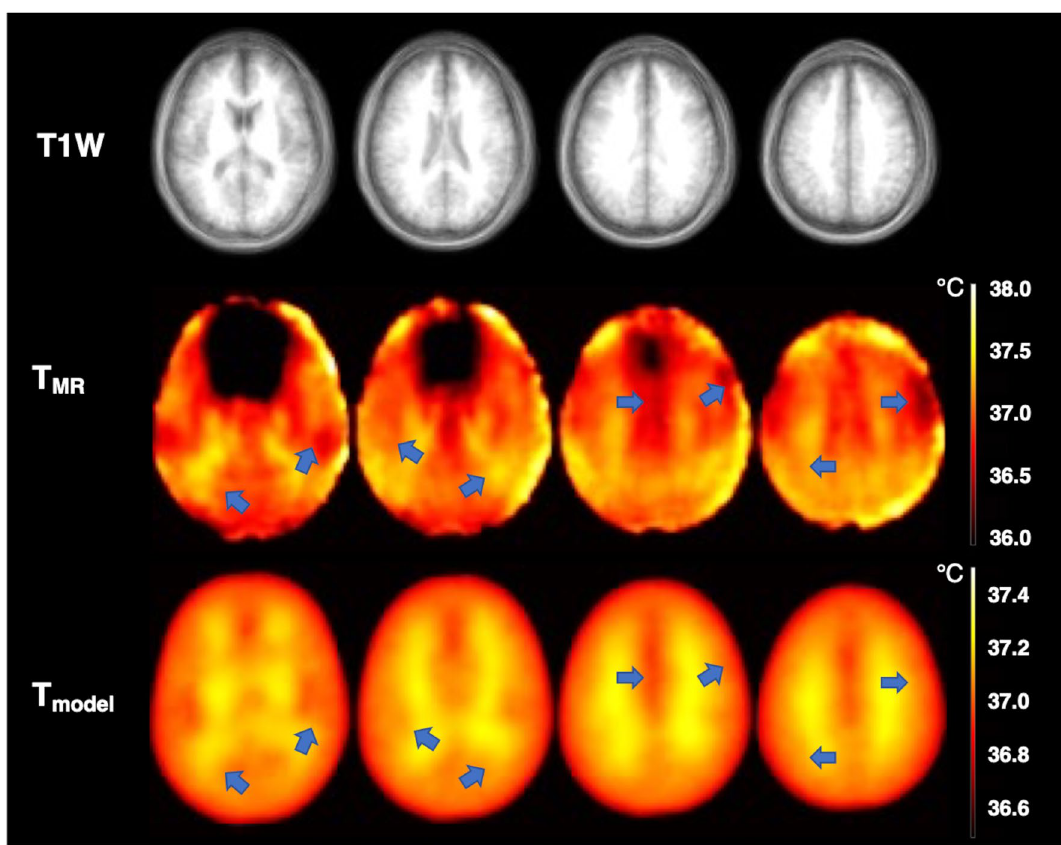
Figure 4. Comparison of group-averaged brain temperature maps from MR measurements and model- predictions for multiple axial slices. The first row shows the anatomical images corresponding to the same axial slice as the temperature maps. While spatial variation exists, the deep brain and subcortical white matter is higher in both model and measurement (highlighted in blue arrows). MR-measured temperatures range from [36.0 °C, 38.0 °C], while model-predicted temperatures range from [36.5 °C, 37.5 °C]. T1W T1-weighted image, T MR MR-measured brain temperatures, T model model-predicted brain